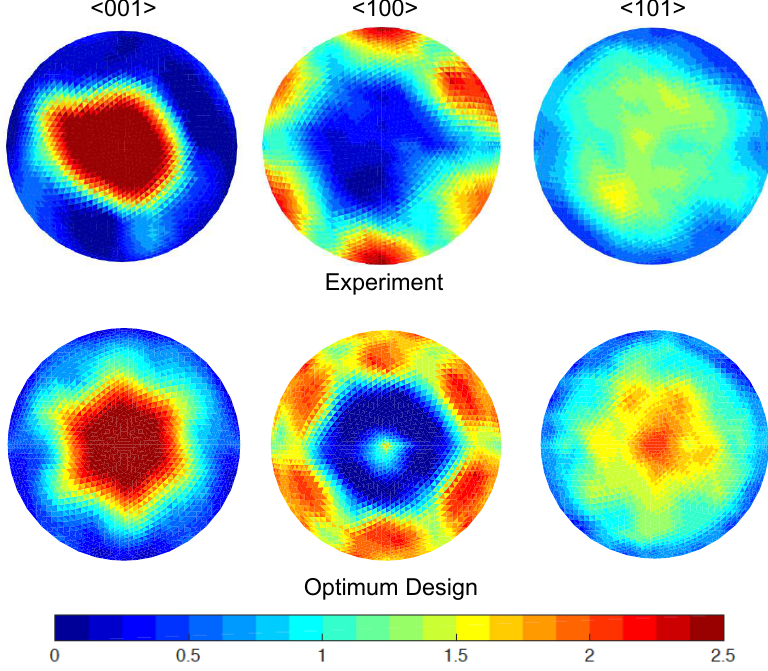
Figure 6. < 001 > , < 100 > and < 101 > PFs at 20% compressive